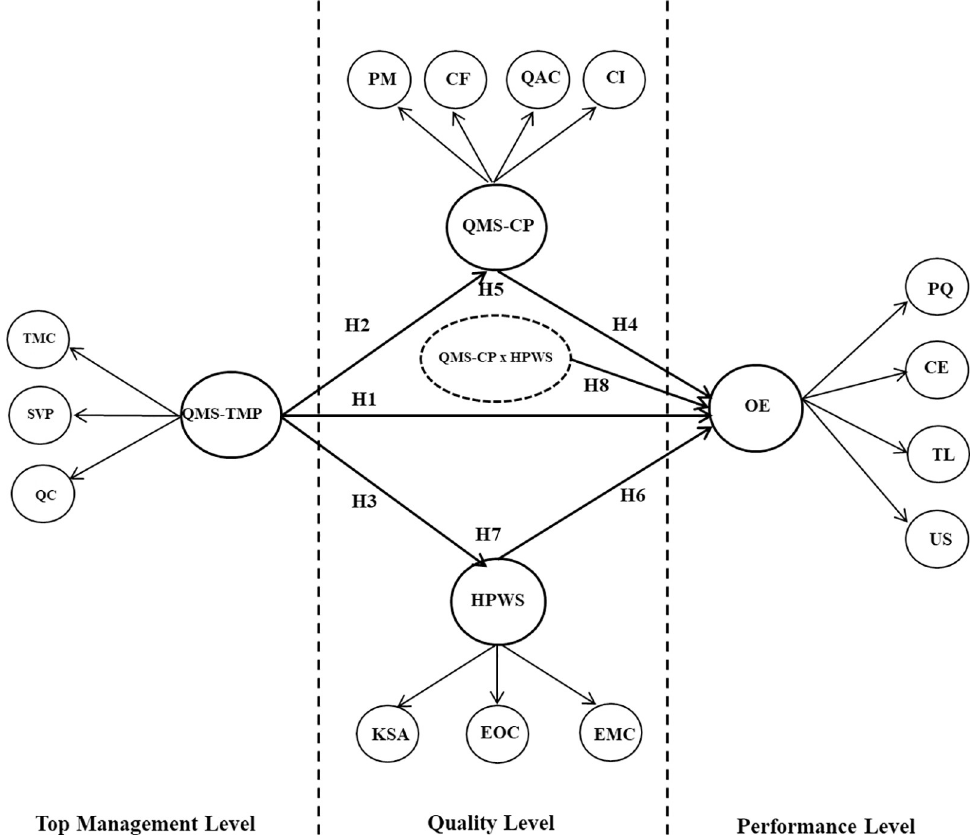
Fig 2. General structure of model with proposed